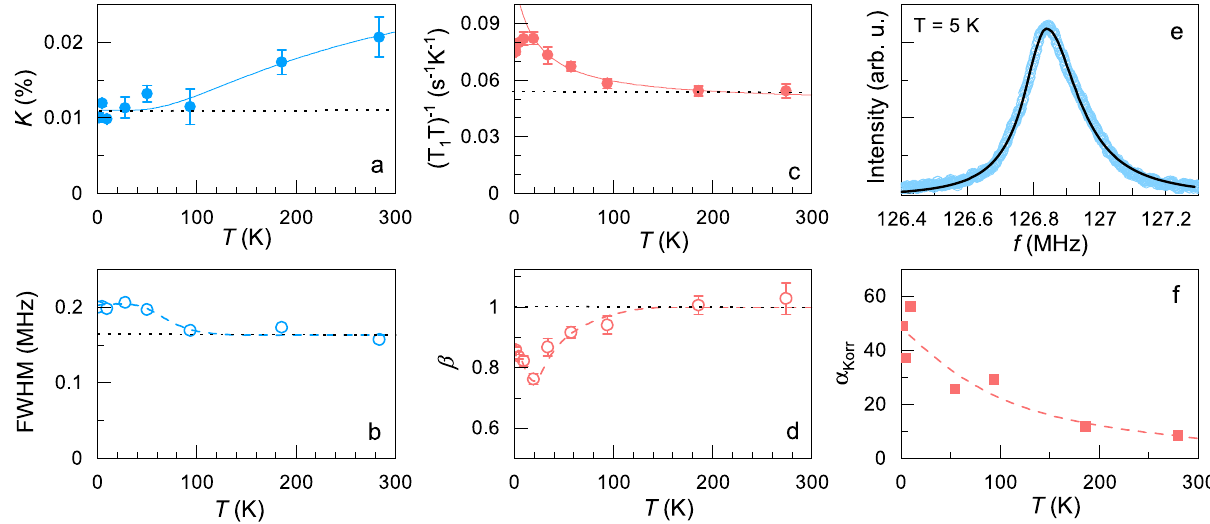
Fig. 4 NMR properties. a Knight shift de fi ned from the peak position of the 29 Si resonance shown in panel e . The continuous line represents the activated form K ¼ A þ B exp ð(cid:2) Δ = k B T Þ , as observed in various Fe-based superconductors, with Δ = 250 K here. b Full width at half maximum of the 29 Si resonance shown in panel e . The line broadening arises from a distribution of Knight shifts values. The dashed line is a guide to the eye. c Spin-lattice relaxation rate divided by temperature. The continuous line is a fi t to the Curie-Weiss form a + c /( T + θ ) with “ Methods ” ). β provides a measure of the width of θ = 22 K. d Stretching exponent β used to fi t the nuclear recoveries in a T 1 experiment (see the distribution of T 1 values. e 29 Si NMR line at T = 5 K in a fi eld of 15 T. The continuous black line is a fi t to an asymmetric Lorentzian form. The slight asymmetry may arise from Knight shift anisotropy as all directions contribute to the spectrum in this powder sample. f Ratio ¼ _ γ 2 = ð 4 π k γ 2 Þ (1/( T ≫ 1 is evidence of predominant antiferromagnetic fl uctuations. The dashed lines in panels b , d , and f are α 2 ). α Korr B 1 T K Korr e n guides to the eye, and the dotted lines in all the panels represent T -independent behavior. Errors are calculated based on the spectrum/ relaxation fi